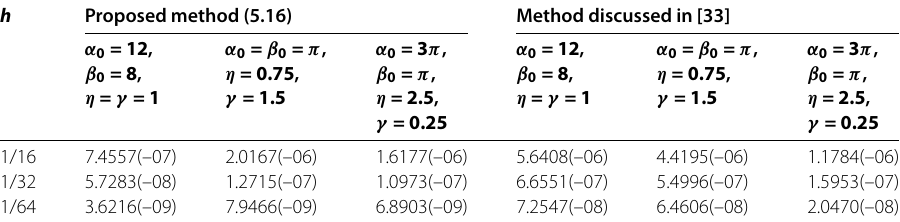
Table 2 Problem 6.1: The maximum absolute